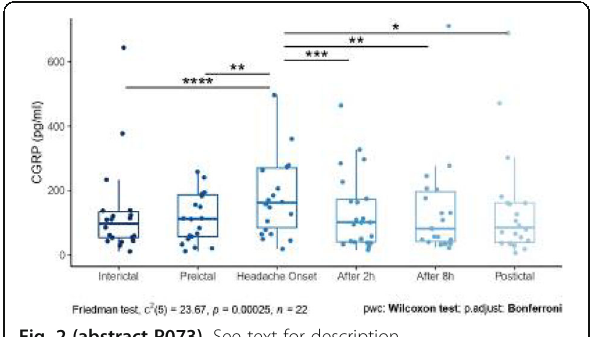
Fig. 2 (abstract P073). See text for